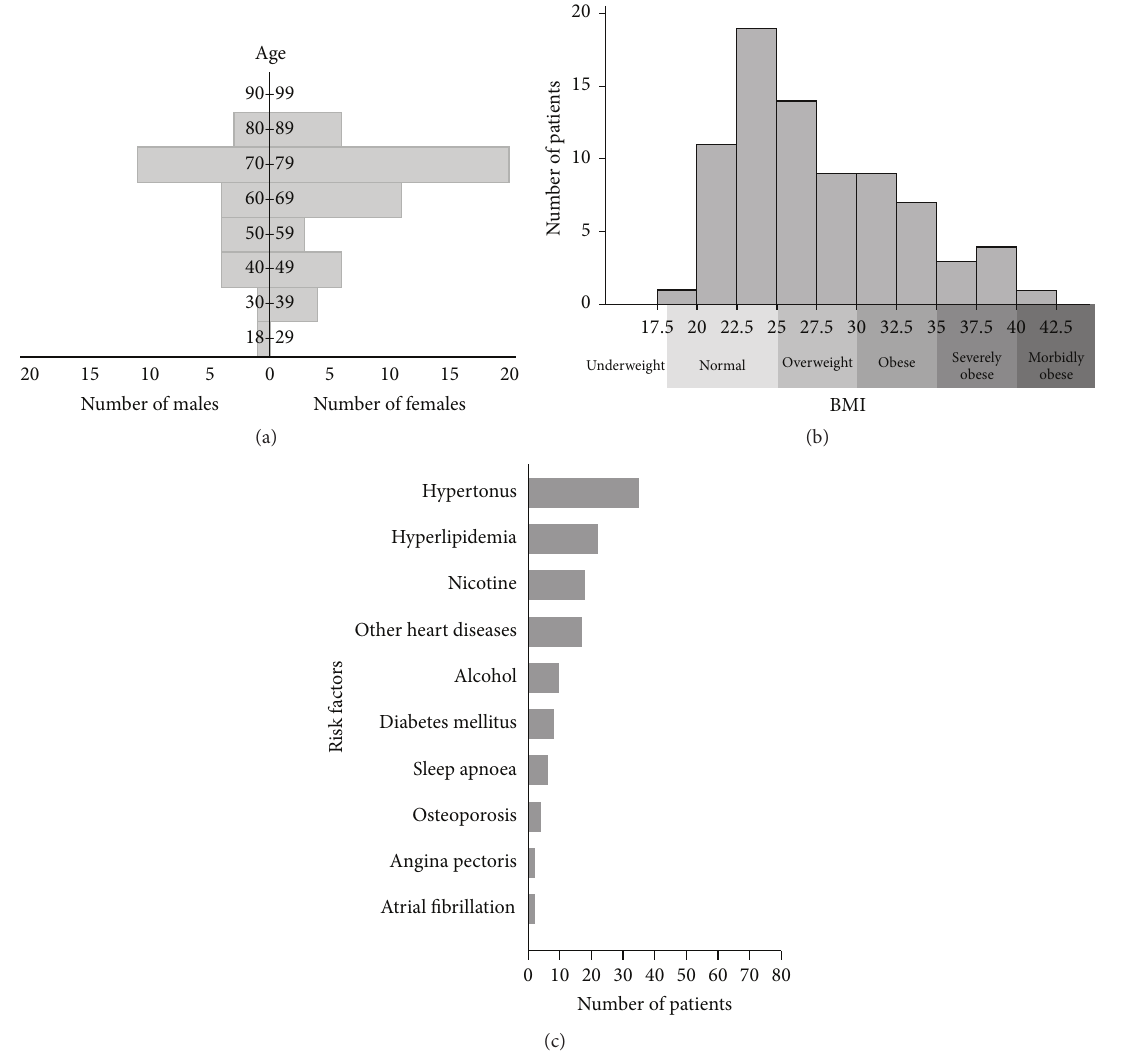
Figure 1: Patient characteristics. (a) Population pyramid, showing the sex and age distribution of the study sample. (b) Histogram of BMI. (c) Bar graph of the incidence of risk factors (see Table 1).